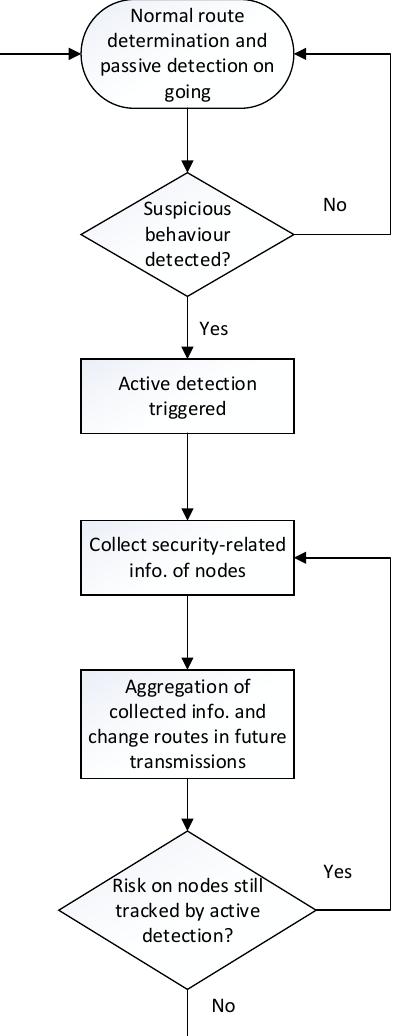
Figure 1. General concept of detection and protection against vampire